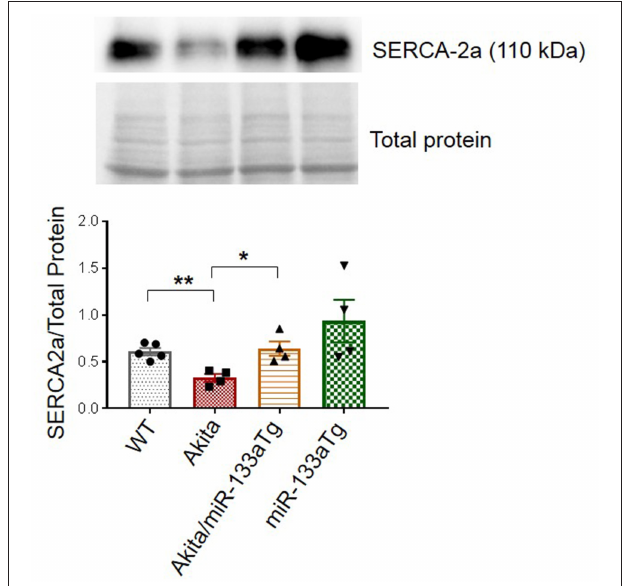
FIGURE 7 | Overexpression of cardiac-specific miR-133a prevents loss of cardiac SERCA2a in Akita. Western blotting showing the representative SERCA2a protein bands and their densitometry analysis in the left ventricle of WT, Akita, Akita/miR-133aTg, and miR-133aTg mice. Values are presented as mean ± SEM. After one-way ANOVA, unpaired Student’s t -test was used for statistical analysis. N = 4–5. * P < 0.05 ; ** P < 0.001.